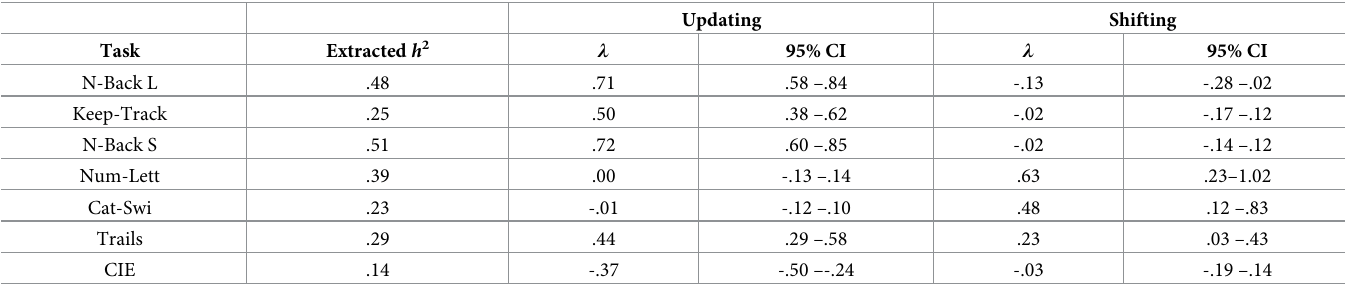
Table 3. Extracted communalities and fully standardized factor loadings (with 95% CI) for our two extracted factors that contained the updating tasks, shifting tasks and CIE